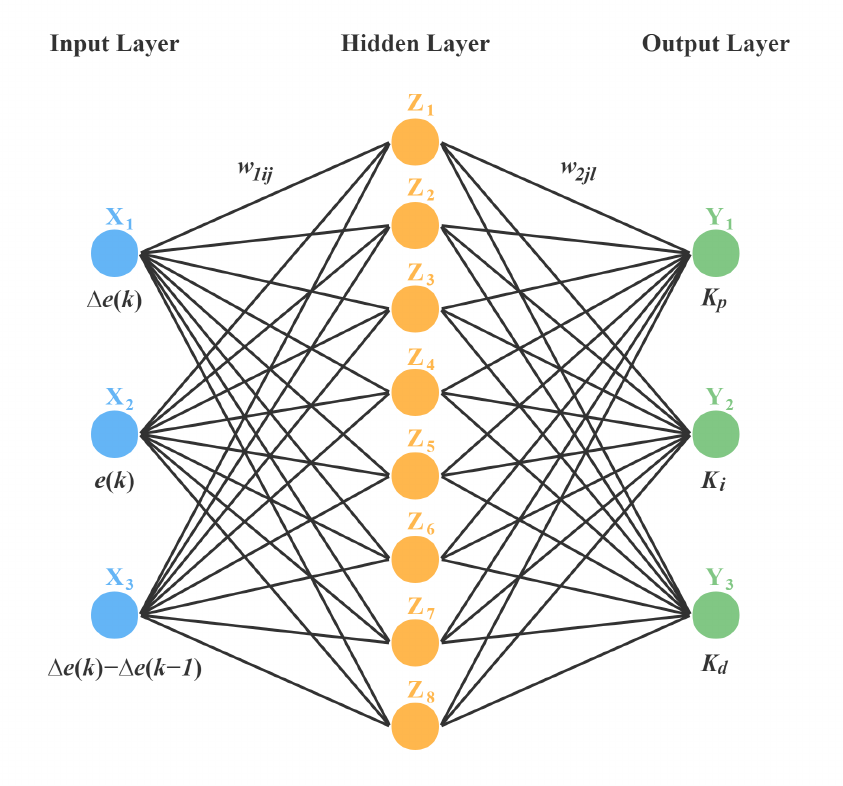
Figure 3. Structure of BP Neural